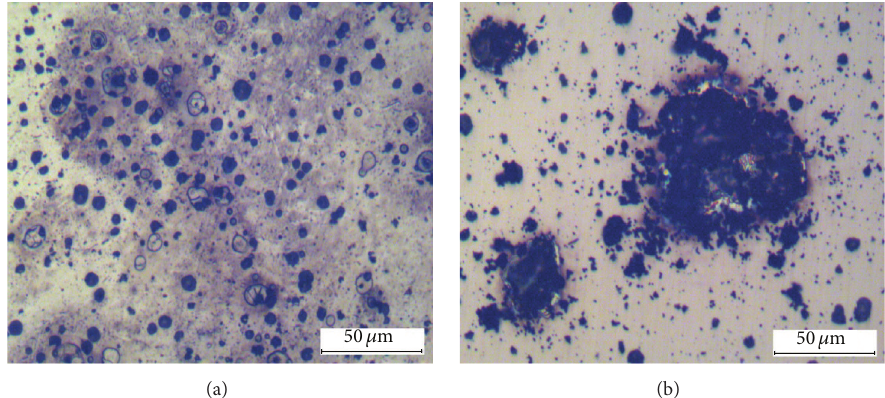
Figure 7: Effect of NaNO 2 addition on surface appearance of ductile cast iron after the immersion test in simulated cooling water for 3 hours at 25 ∘ C; (a) 0ppm NaNO 2 and (b) 10,000 ppm NaNO 2 .